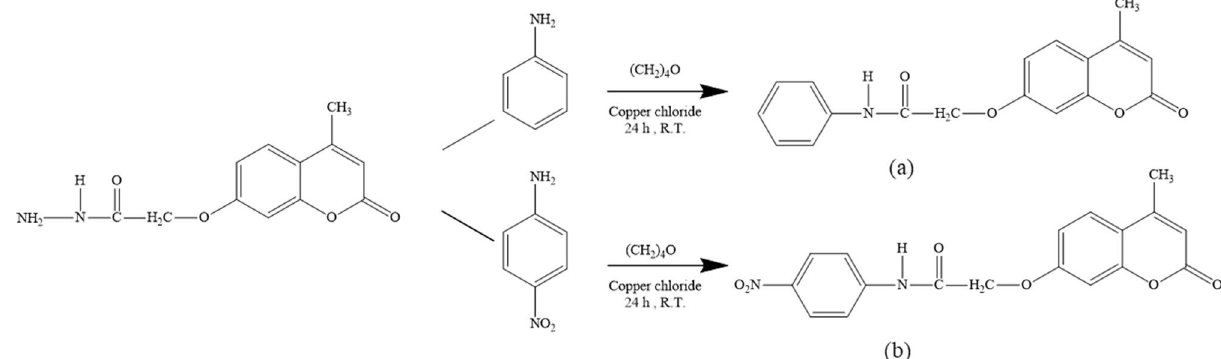
Figure 8. Synthesis of ( a ) 4-methylcoumarin-7-yloxy-N-phenyl acetamide and ( b ) 4-methylcoumarin-7-yloxy- N-4-nitrophenyl